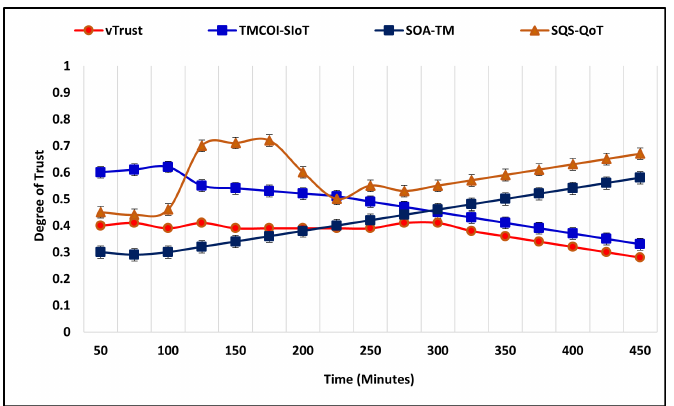
Figure 4. Malicious nodes detection with 50